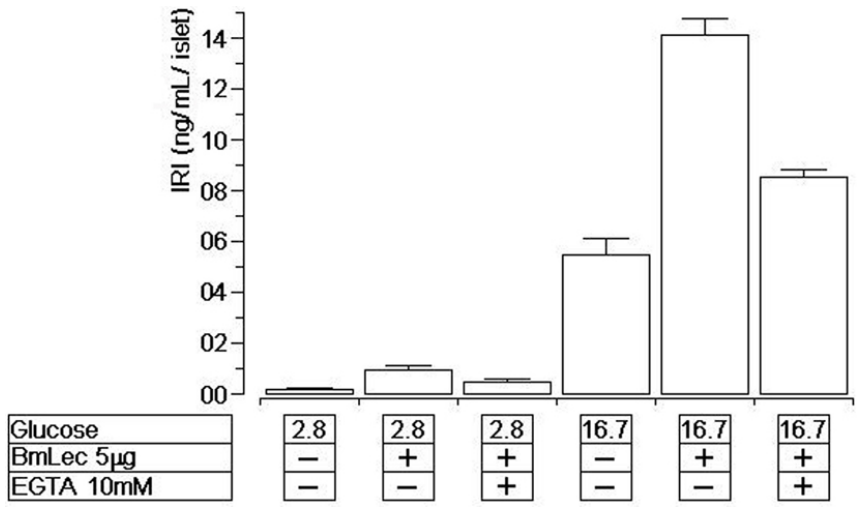
Figure 6. Insulin secretion dose-response curve of BmLec on isolated pancreatic β-cells at high and low glucose